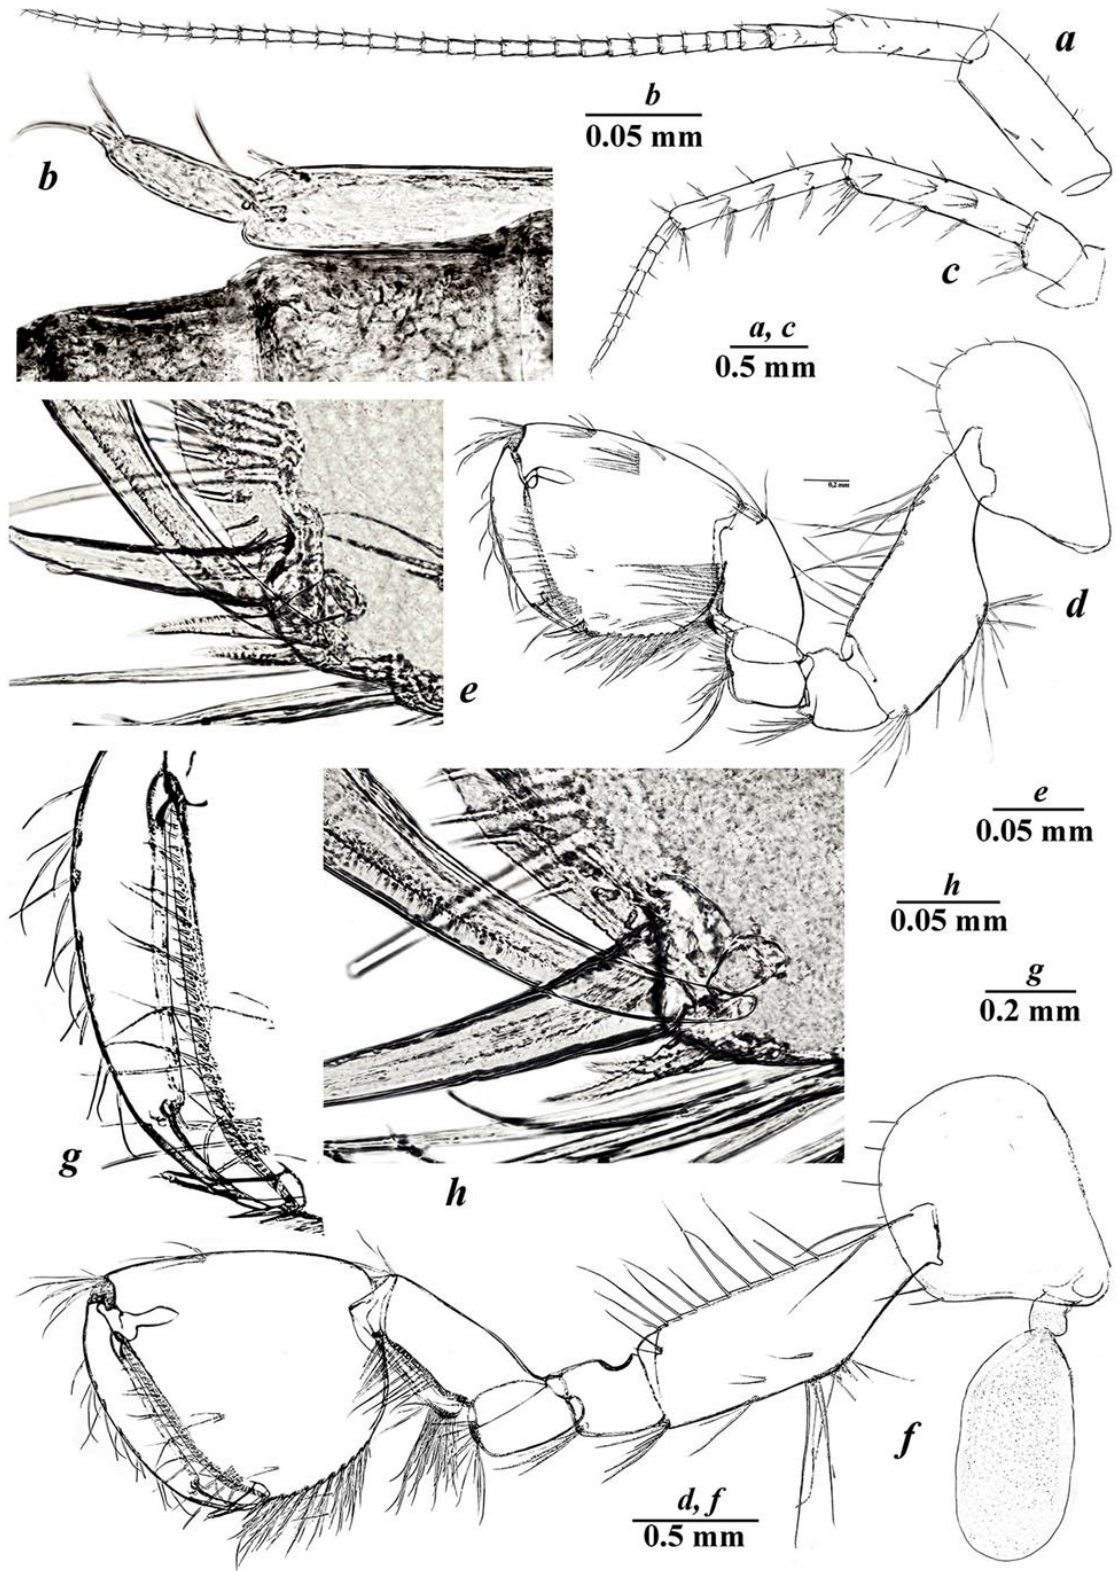
Figure 3. Niphargus tarkhankuticus sp. nov., male: ( a ) antenna I; ( b ) accessory flagellum of antenna I; ( c ) antenna II; ( d ) gnathopod I; ( e ) distoventral corner of GnI; ( f ) gnathopod II; ( g ) dactylus and distoventral palmar margin of GnII; ( h ) distoventral corner of chela of